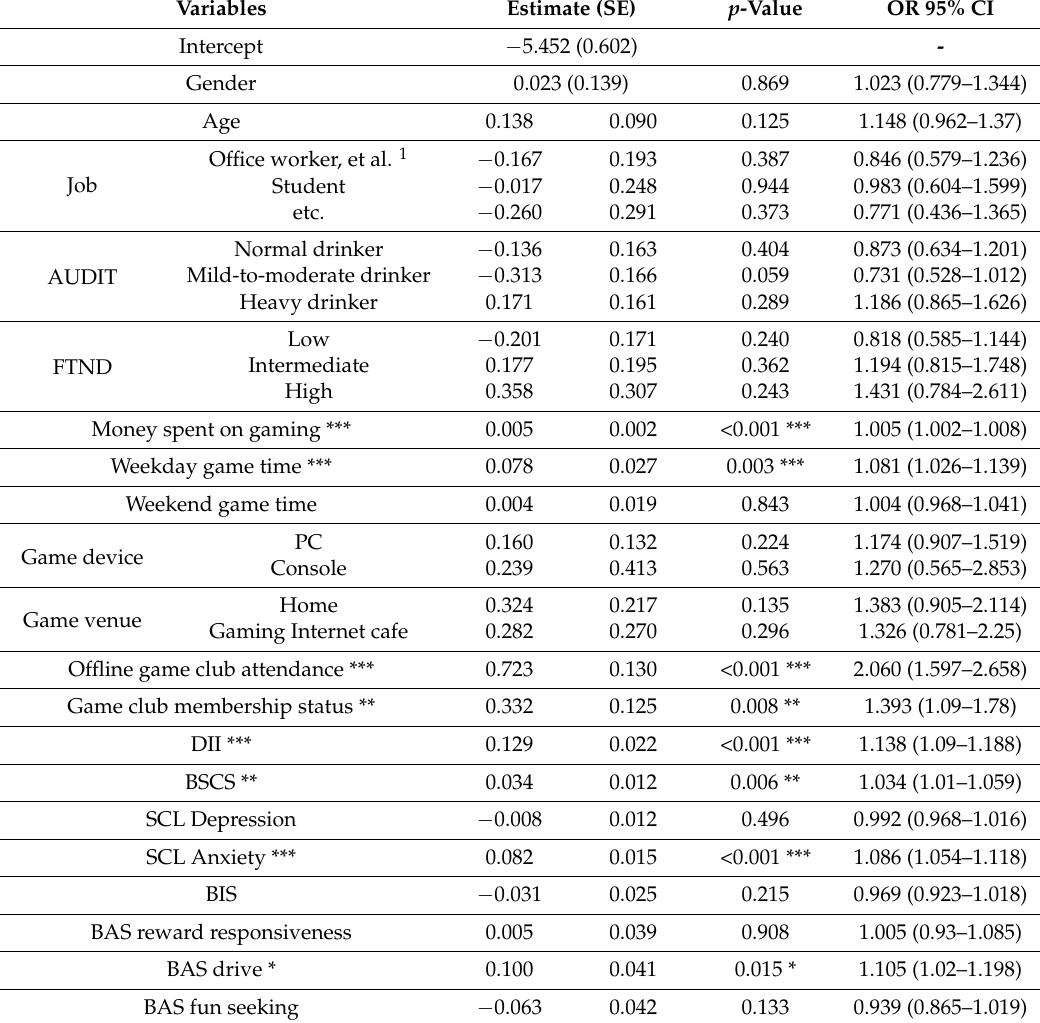
Table 4. Risk factors predicting